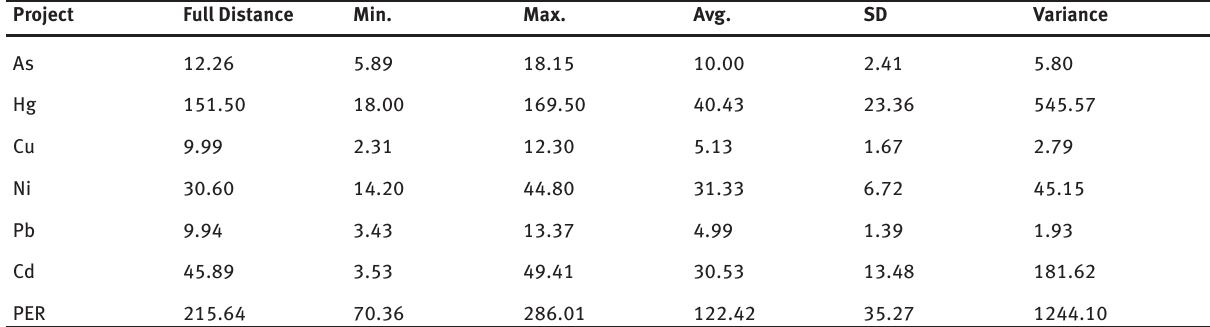
Table 3: Statistics of the risk index.